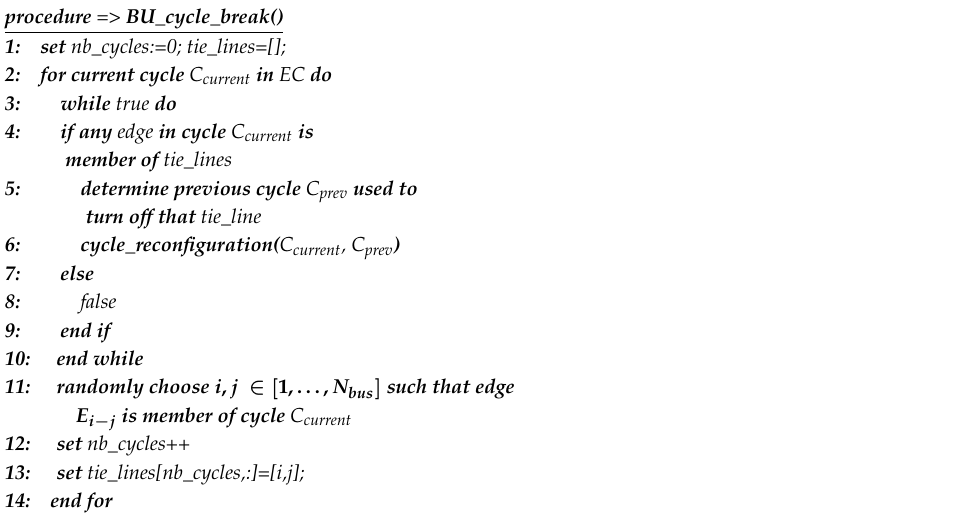
Algorithm 3. Pseudocode for BU cycle break algorithm.